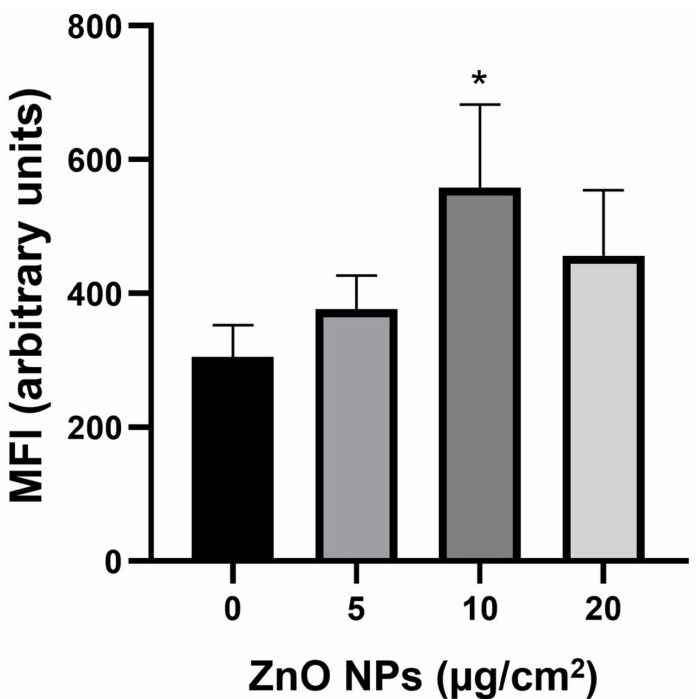
Figure 6. ZnO NPs effects on the cellular redox state. Cells (3 × 10 3 /well) were exposed to 0, 5, 10, and 20 µ g/cm 2 of ZnO NPs for 1 h. The cellular redox state was evaluated by H 2 DCFDA and analyzed by flow cytometry. Results were expressed as mean ± standard deviation of three independent experiments. MFI = mean intensity fluorescence. * p < 0.05 compared with